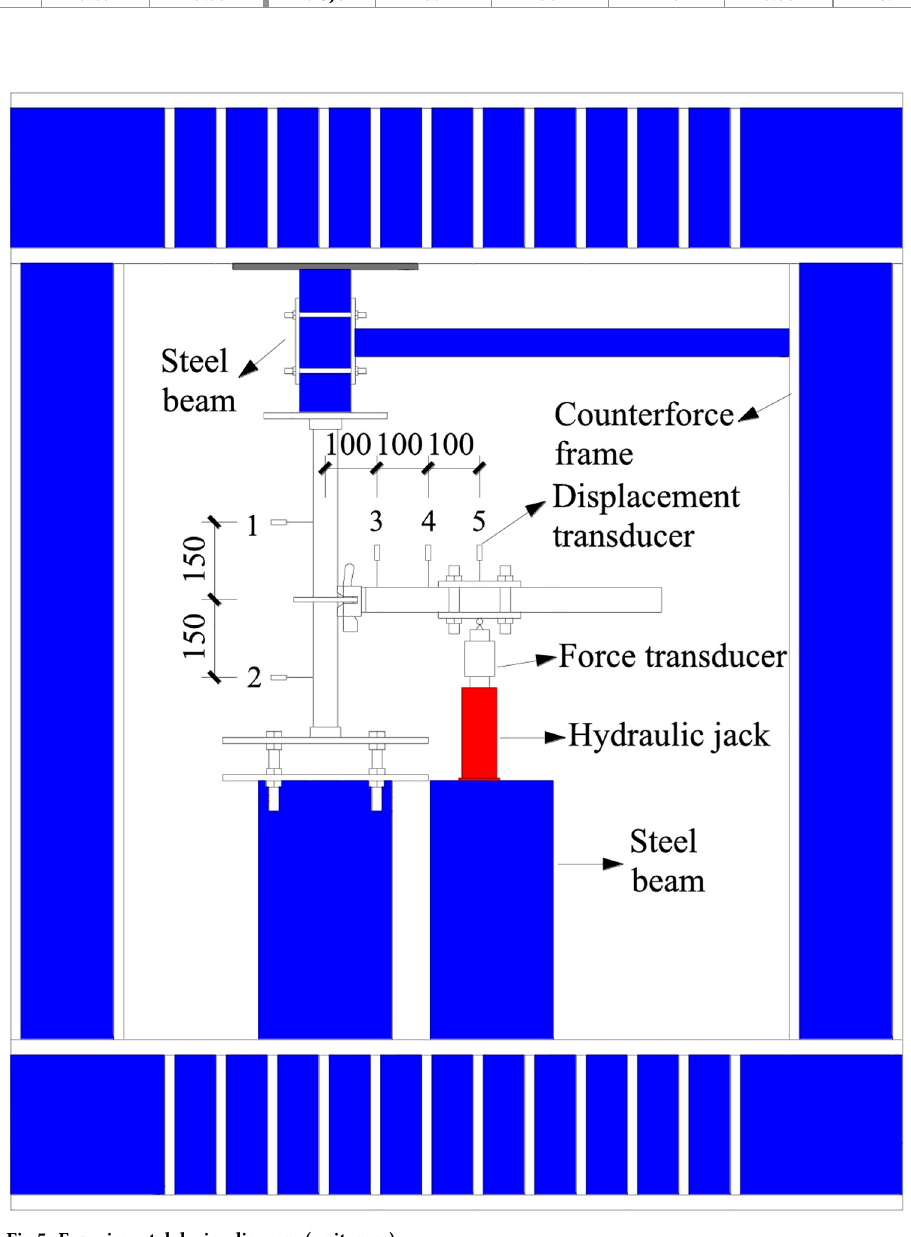
Fig 5. Experimental device diagram (unit: